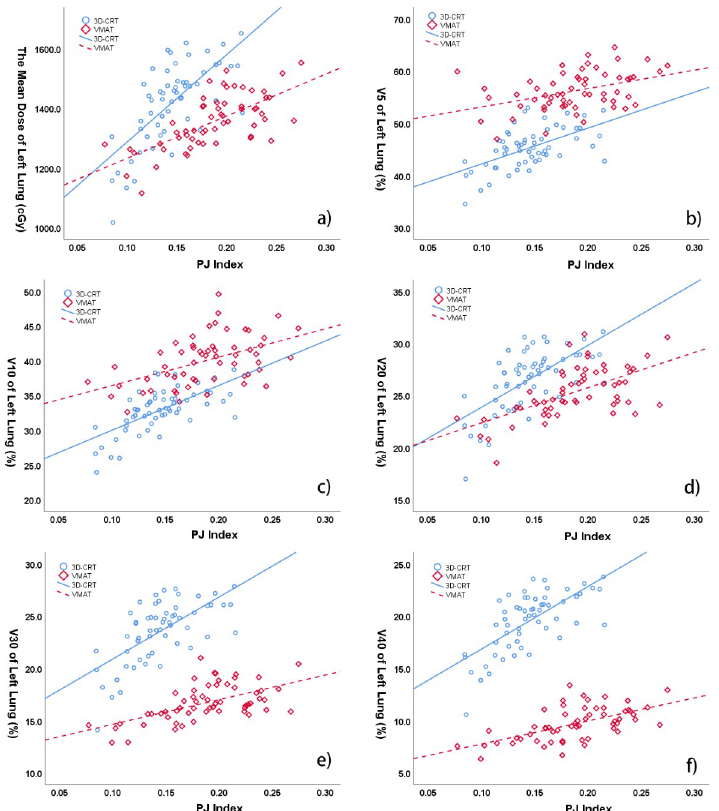
Fig 3. Correlation between PJ index and dose metrics of left lung in 3D-CRT and VMAT. a) PJ index and MLLD (r = 0.697 for 3D-CRT, p < 0.01; r = 0.676 for VMAT, p < 0.01); b) PJ index and (V 5 of left lung: r = 0.568 for 3D-CRT, p = 0.1; r = 0.407 for VMAT, p < 0.01); c) PJ index and V 10 of left lung (r = 0.663 for 3D-CRT, p < 0.01; r = 0.495 for VMAT, p < 0.01); d) PJ index and V 20 of left lung (r = 0.659 for 3D-CRT, p < 0.01; r = 0.6 for VMAT, p < 0.01); e) PJ index and V 30 of left lung (r = 0.66 for 3D-CRT, p < 0.01; r = 0.578 for VMAT, p < 0.01); f) PJ index and V 40 of left lung (r = 0.691 for 3D-CRT, p < 0.01; r = 0.594 for VMAT, p <